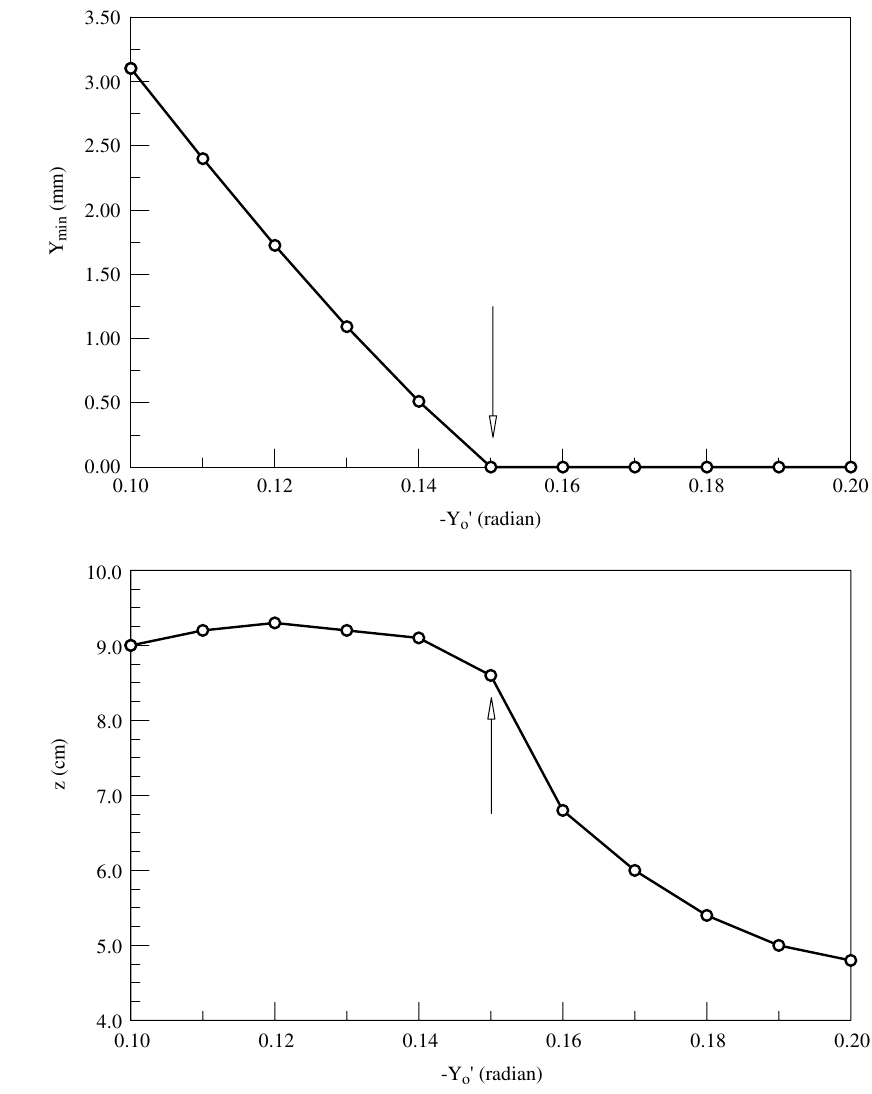
FIG. 2. Transformation by an anisotropic thin lens, solutions of the KVequations. Variations with initial vertical envelope angle (cid:1) 5 = 3 . Arrows show the optimal focus condition. (a) Minimum vertical half-width Y =f Y 0 for f x y 0 lens to the vertical